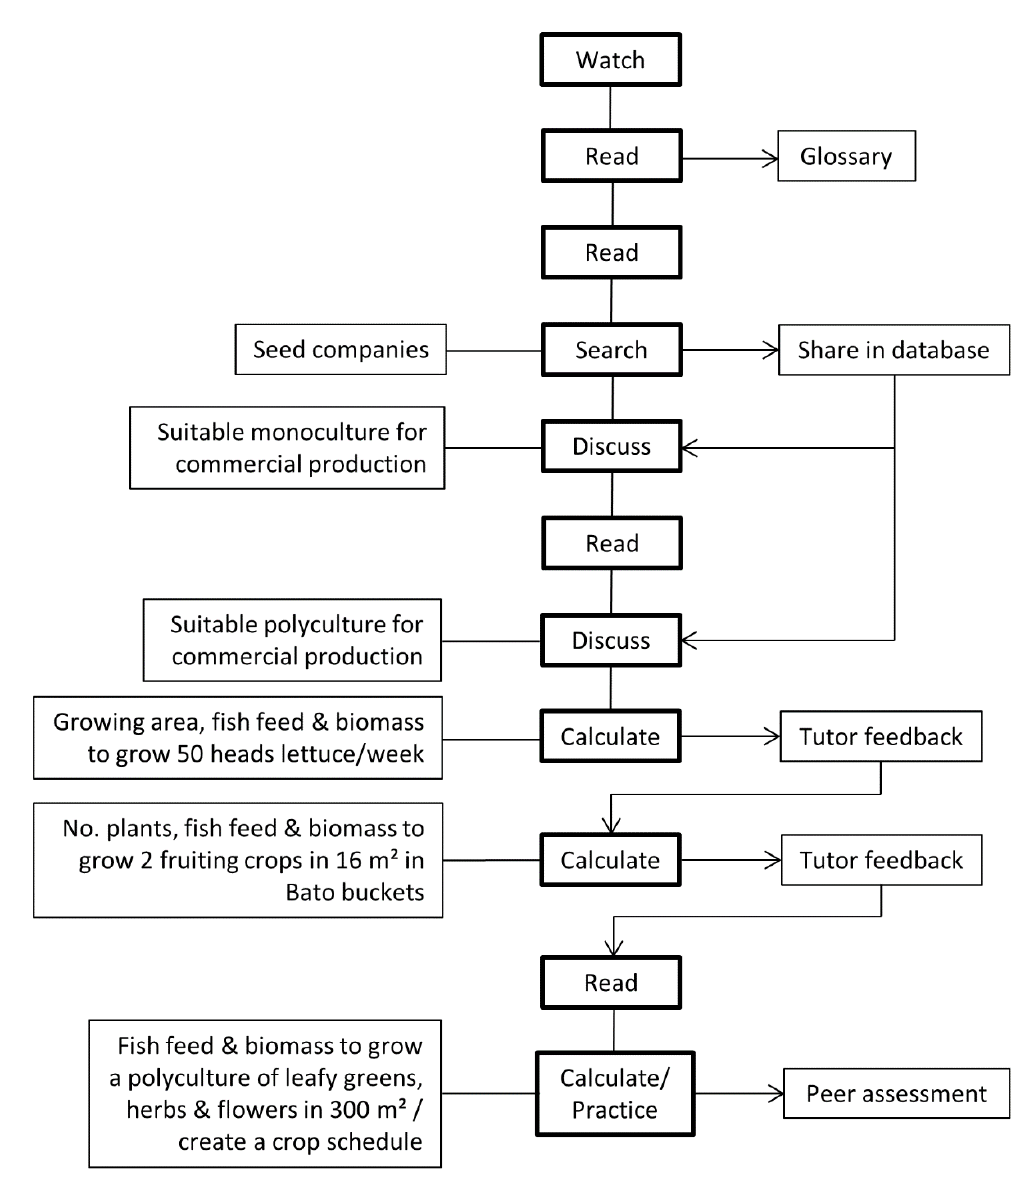
Figure 1. Instructional scaffolding in Module 7—Plant varieties.